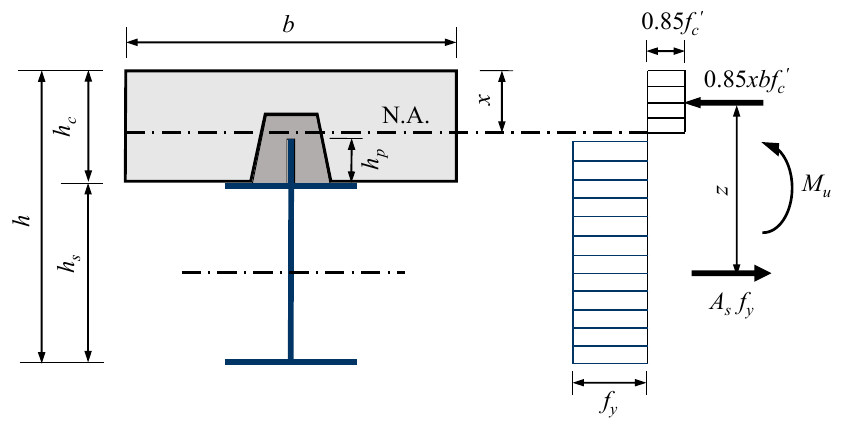
Figure 16. Sectional analysis for plastic resistance moment.